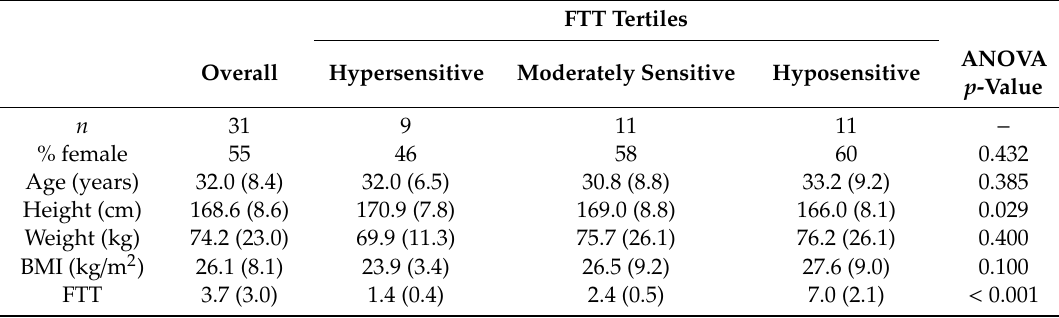
Table 1. Characteristics of